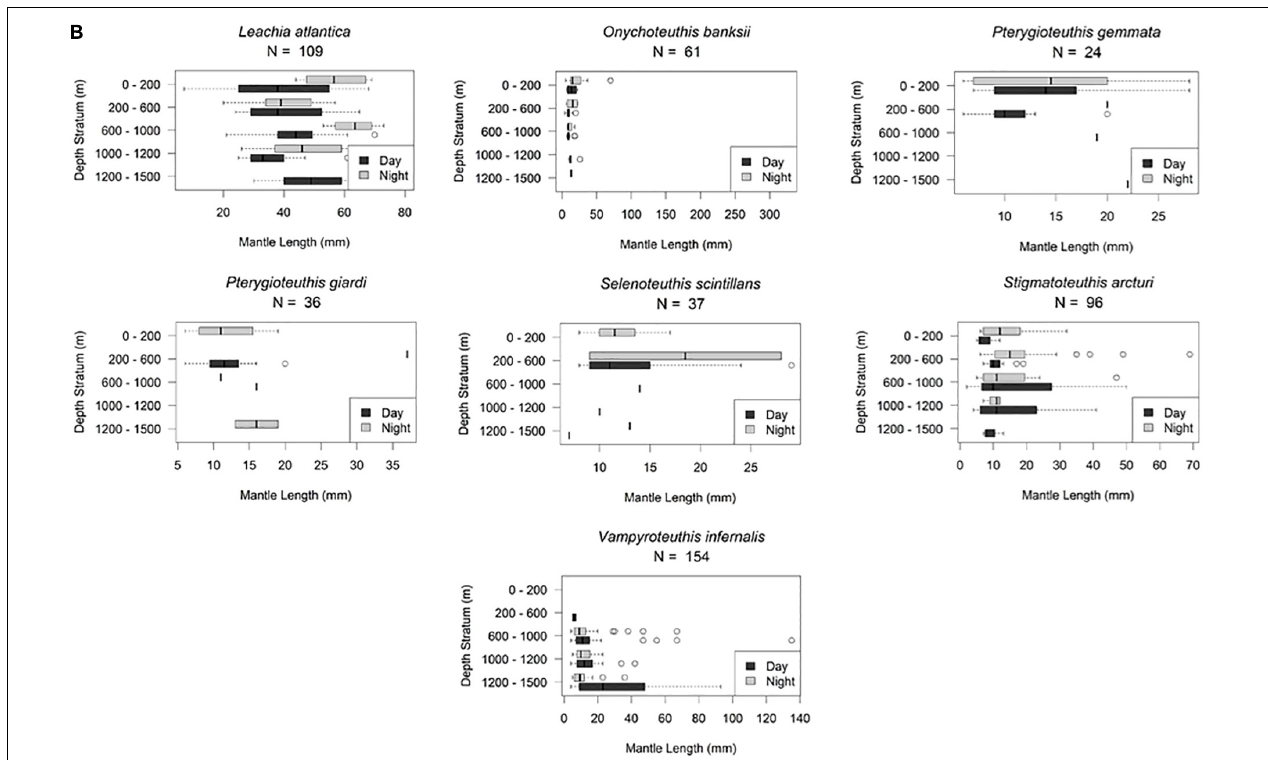
FIGURE 9 | (A,B) Cephalopods showing no evidence of ontogenic shift. Horizontal line, median; box limits, 1st and 3rd quartiles; circles, outliers.